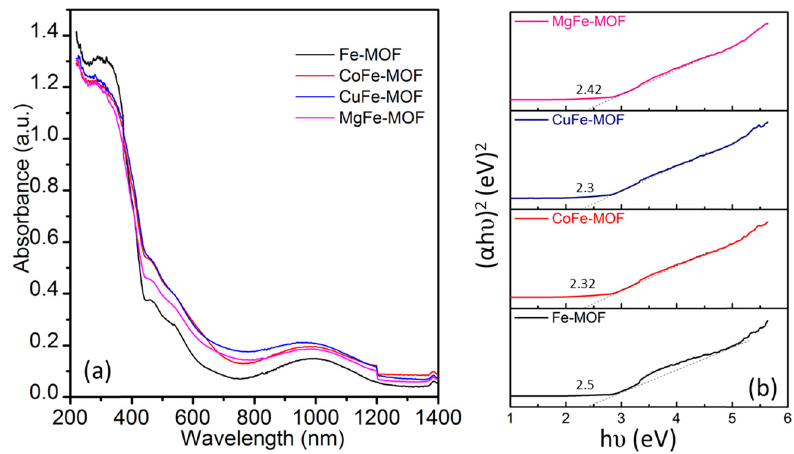
Figure 5: ( a ) UV - Vis di ff use re fl ectance spectra ( UV - Vis DRS ) and ( b ) bandgap energies ( Eg ) of M/Fe - MOF ( M = Co, Cu, and Mg )